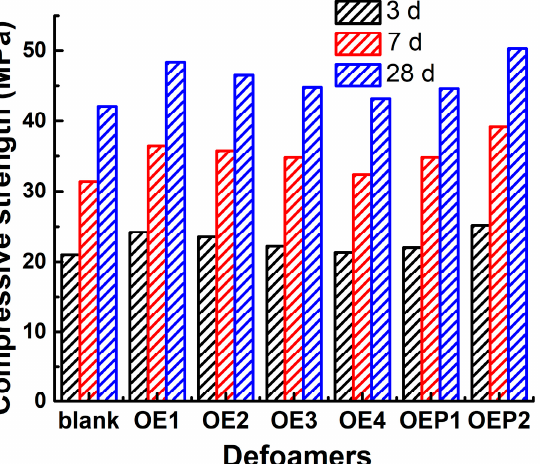
Figure 9. Compressive strengths of the hardened mortar samples after the incubation times of 3 (black), 7 (red) and 28 (blue) days mixed with various polyether-type